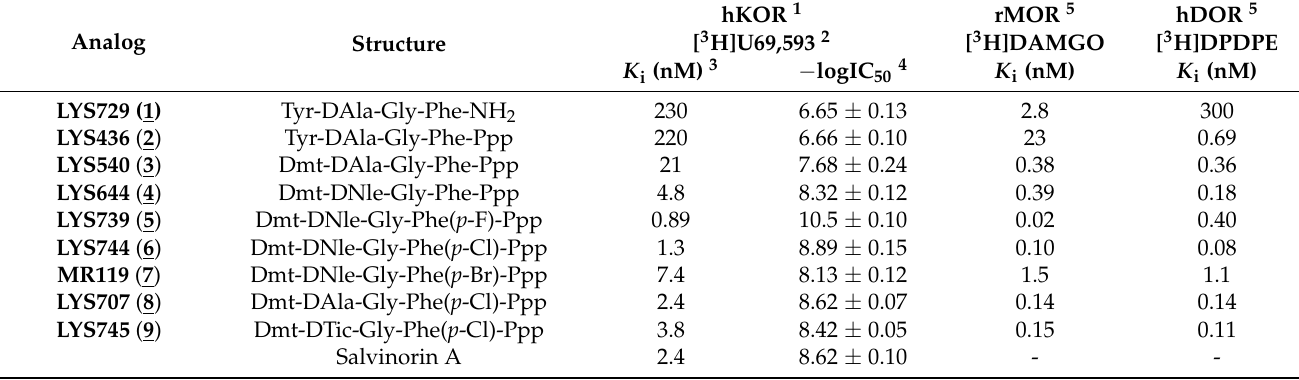
Table 1. Structures and binding affinities of enkephalin analogs 1 – 9 at the KOR, MOR, and